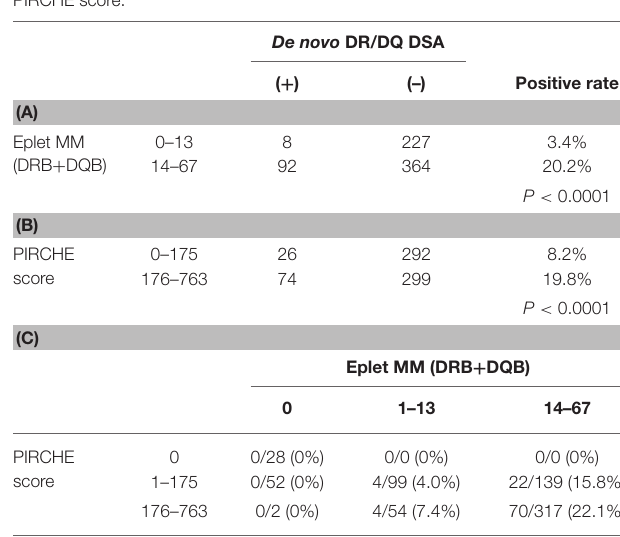
TABLE 2 | Incidence of de novo DR/DQ DSA by (A) eplet mismatch and (B) PIRCHE score, (C) de novo DSA positive rate by both of eplet mismatch and PIRCHE